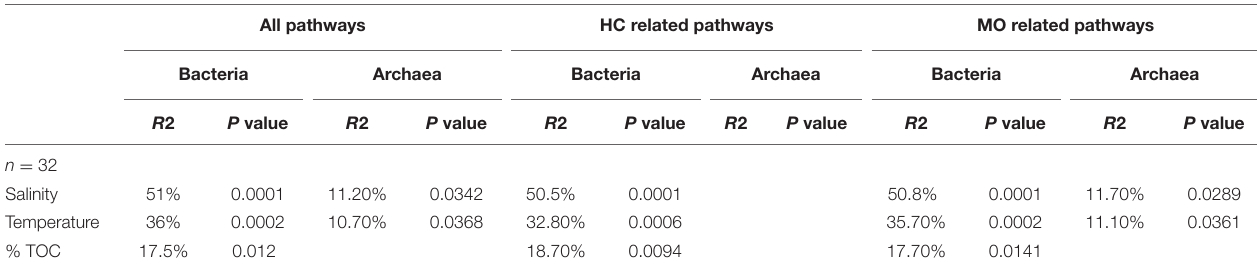
TABLE 2 | PerMANOVA results for environmental parameters against Bray-Curtis matrices of all reconstructed bacterial metabolic pathways, metabolic pathways (from the KEGG database) related to organic matter metabolism (OM, n = 113 for bacteria and n = 101 for archaea), and hydrocarbons (HC, n = 14 for Bacteria and n = 10 for